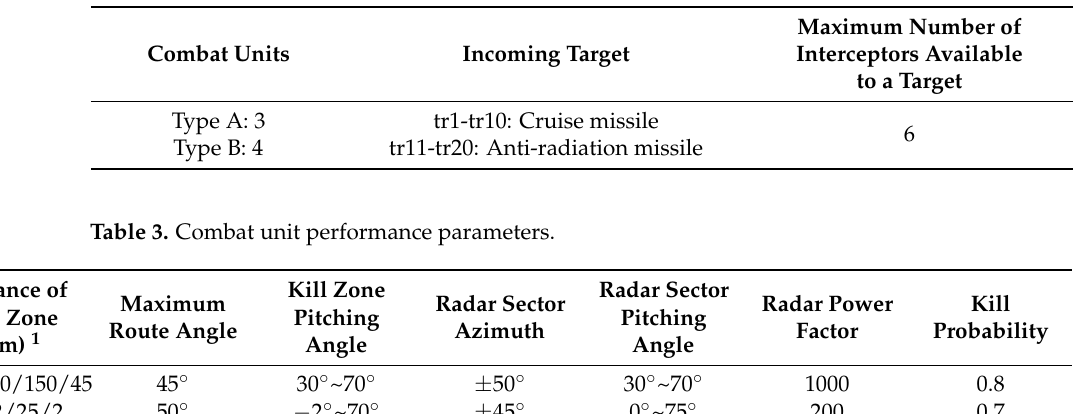
Table 2. Combat unit and incoming target information.